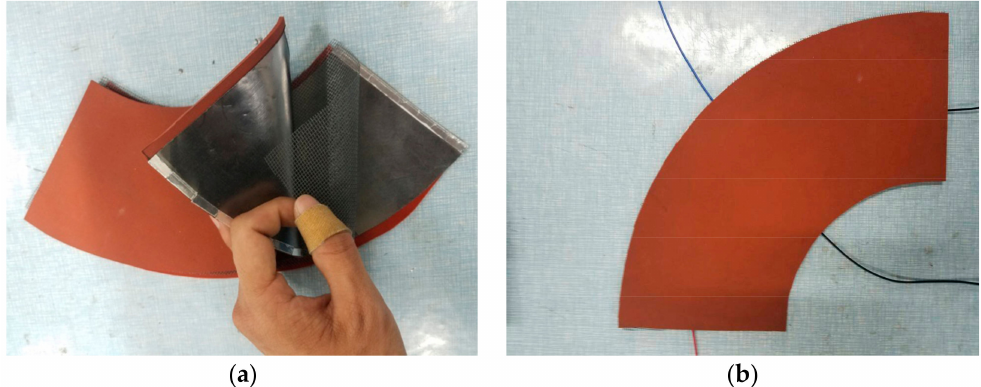
Figure 13. Sensor sample: ( a ) before packaging; ( b ) after